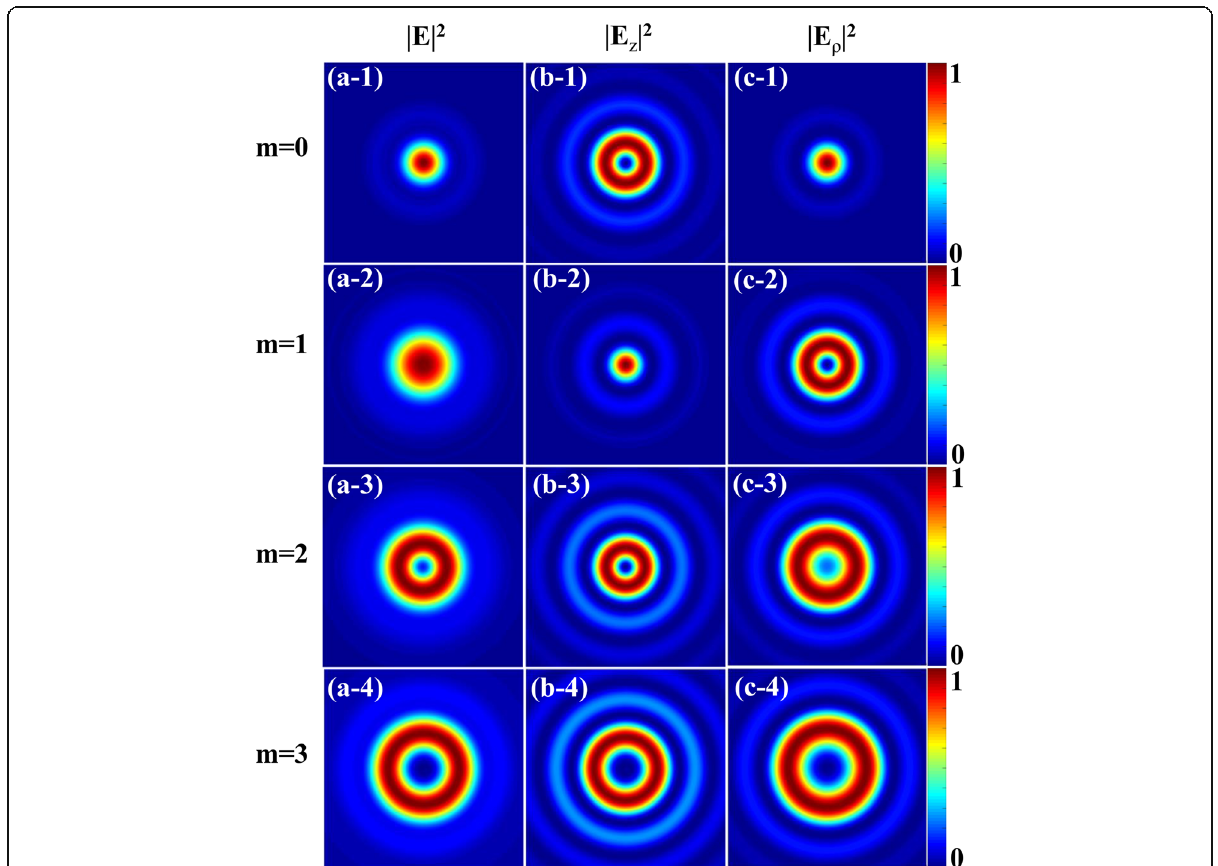
Fig. 1 Intensity profile for the tightly focused left-hand CPAVBs with n = 1 for different topological charges. a-1 to a-4 , b-1 to b-4 , and c-1 to c-3 are the total intensity | E | 2 and longitudinal | E z | 2 and radial | E ρ | 2 components,